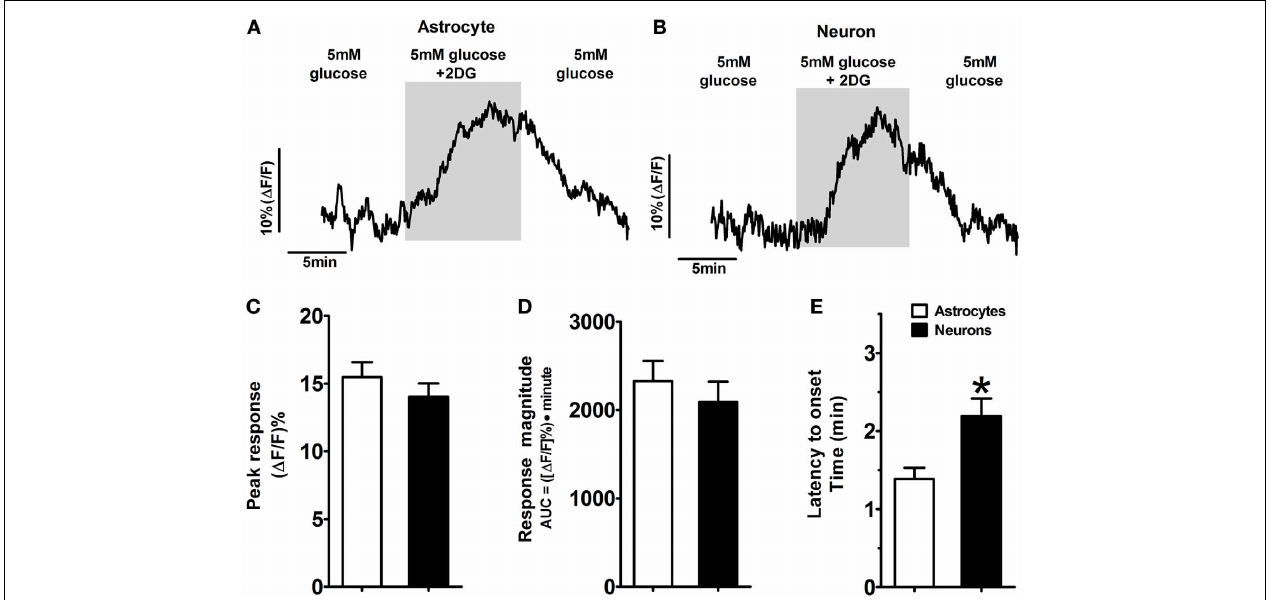
FIGURE 4 | Activated response patterns of astrocytes and neurons in the hindbrain slice preparation to glucoprivic challenge (i.e., 2-DG-positive). Approximately 40% of NST-astrocytes and 25% of NST-neurons responded to a glucoprivic solution consisting of 5mM 2-Deoxy-D-glucose (2-DG) dissolved in media containing normal (5mM) glucose concentrations with an increase in activity ( Tables 1 , 2 ). Examples of 2-DG-positive astrocytes and neurons activated in response